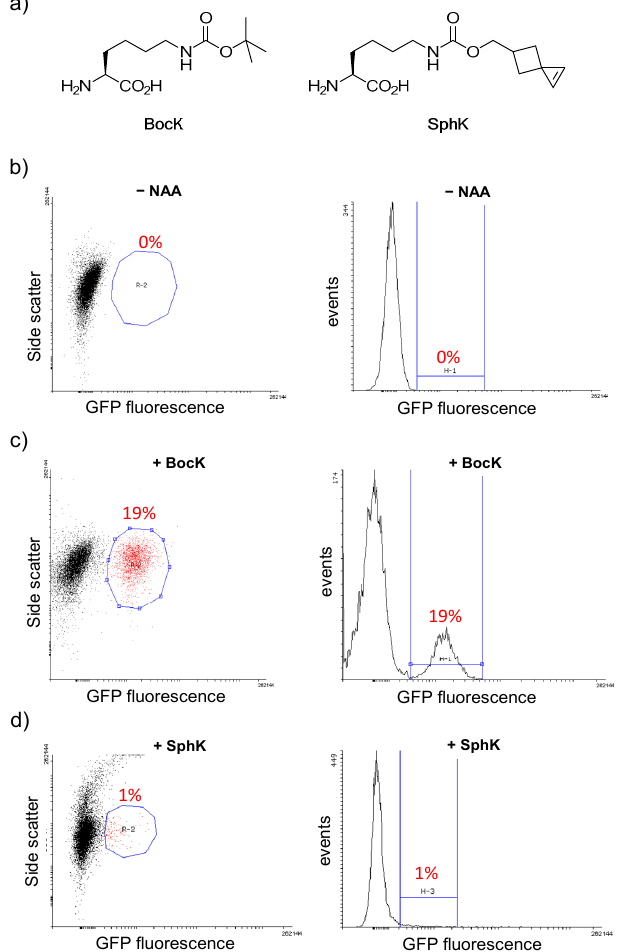
Figure 2. FACS analyses of the PylRS library activity. ( a ) Structures of BocK and SphK. ( b – d ) FACS analysis of Acella cells co-expressing the PylRS library and sfGFP-204TAG in the absence of any non-natural amino acid ( b ) or the presence of 2 mM BocK ( c ) or the presence of 1 mM SphK ( d ). The regions showing GFP+ cells are circuled and quantified in the dot blots. The percentage of fluorescent cells is also marked in the hostograms. Ten thousand events were recorded for each FACS